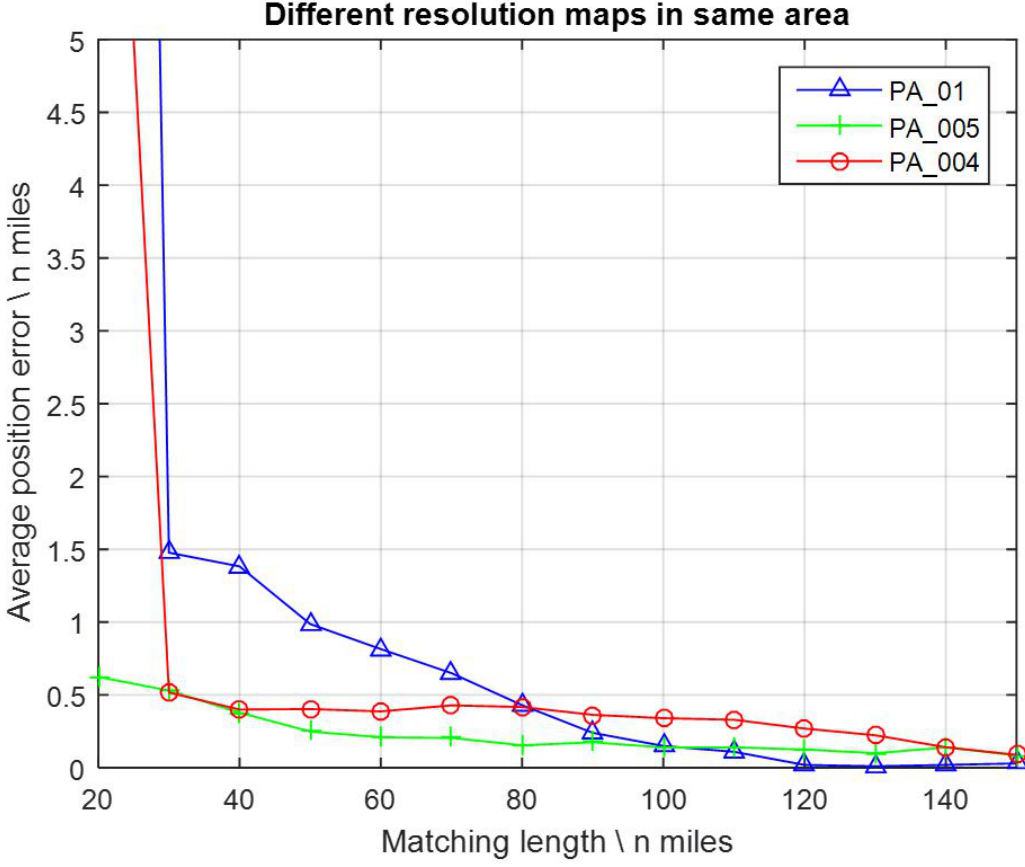
Figure 6. Average position errors with gravity maps PA_01, PA_005, and